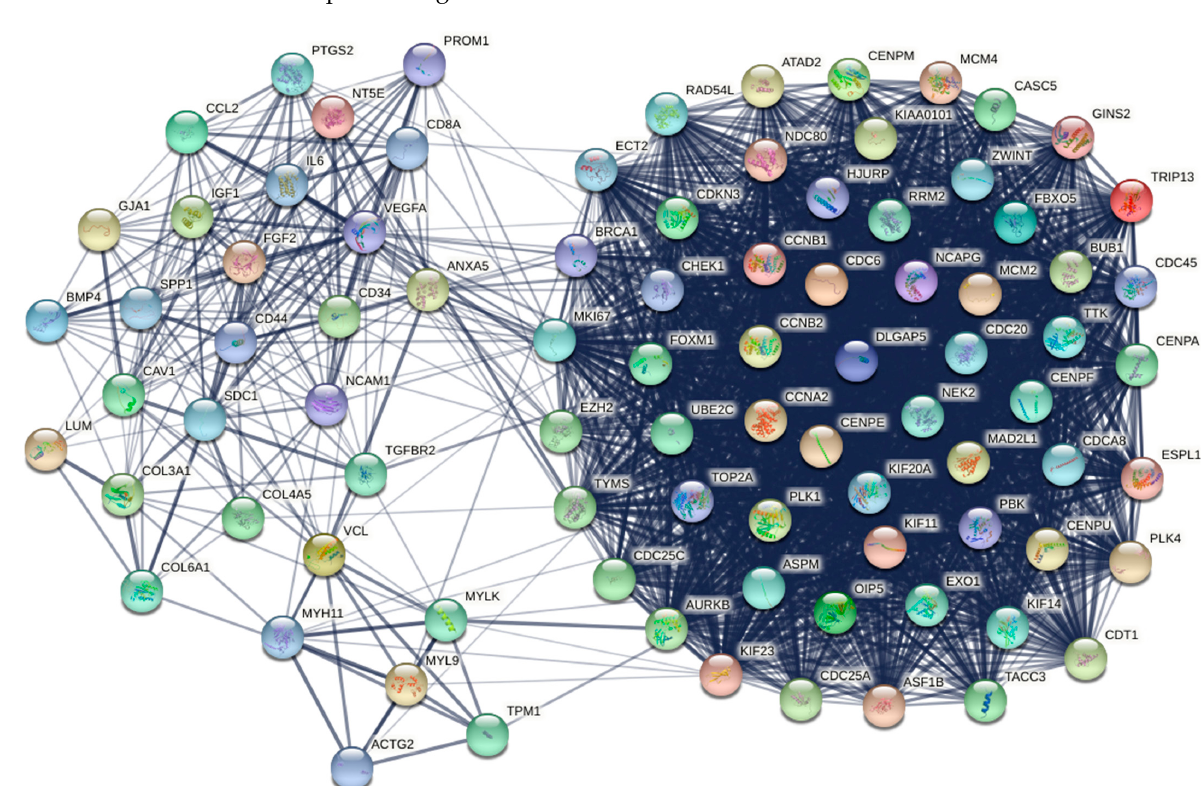
Figure 9. The PPI network of the final 87 hub genes. Nodes represent proteins and edges represent protein–protein associations. Line thickness represents the confidence score of a functional